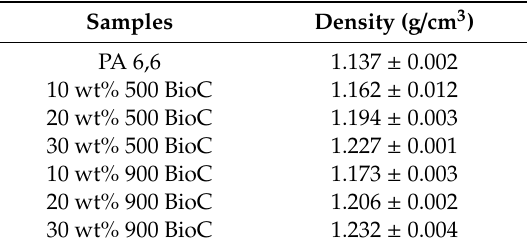
Table 1. Measured density of PA66 and its biocarbon-based composites at different filler content.